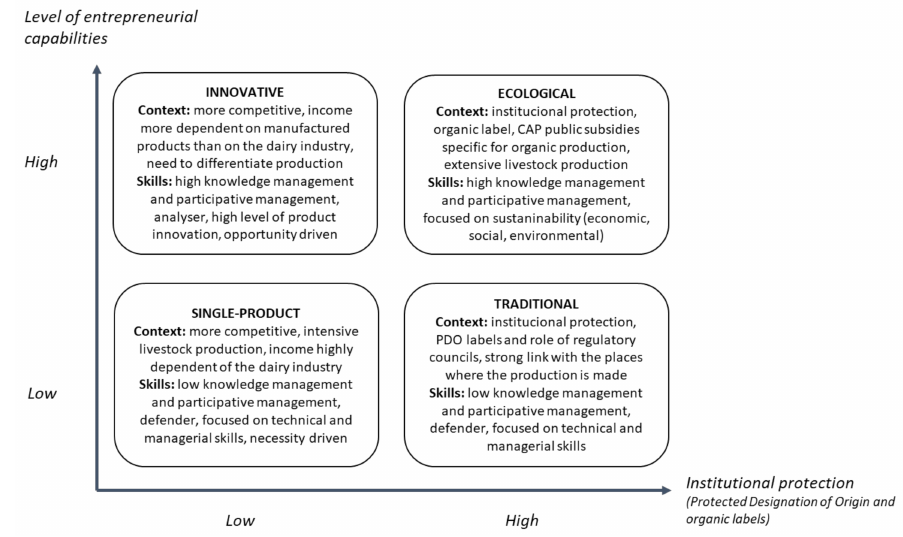
Figure 1. Matrix context and entrepreneurial